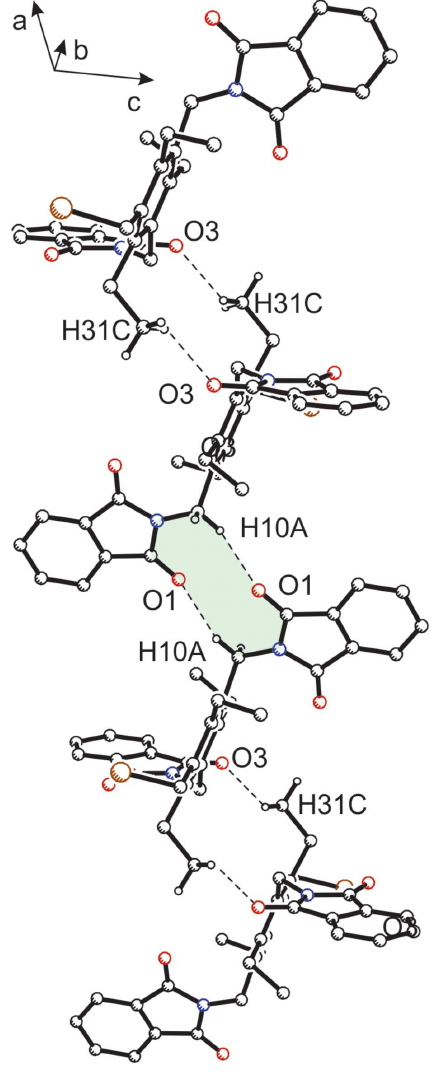
Figure 4 Packing excerpt of 2 showing C—H (cid:2)(cid:2)(cid:2) O hydrogen bonds (dashed lines), which participate in the formation of the supramolecular ring motif with graph set R 2 (10). Hydrogen atoms of subunits that are excluded from 2 intermolecular hydrogen bonding are omitted for